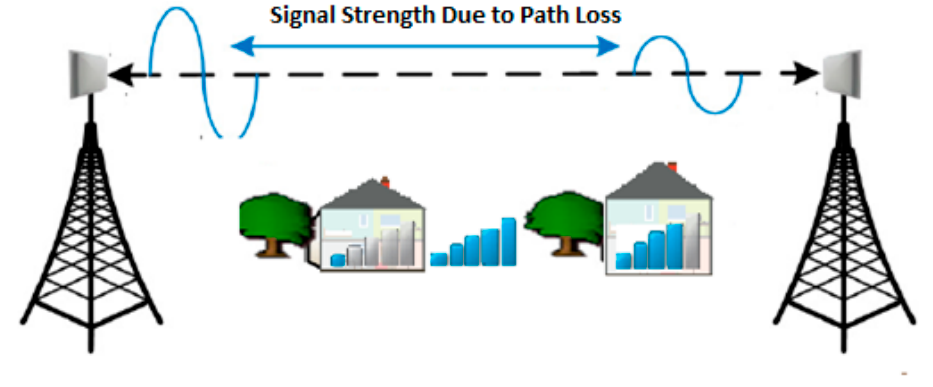
Figure 1. Different path loss sensor (signal strength).